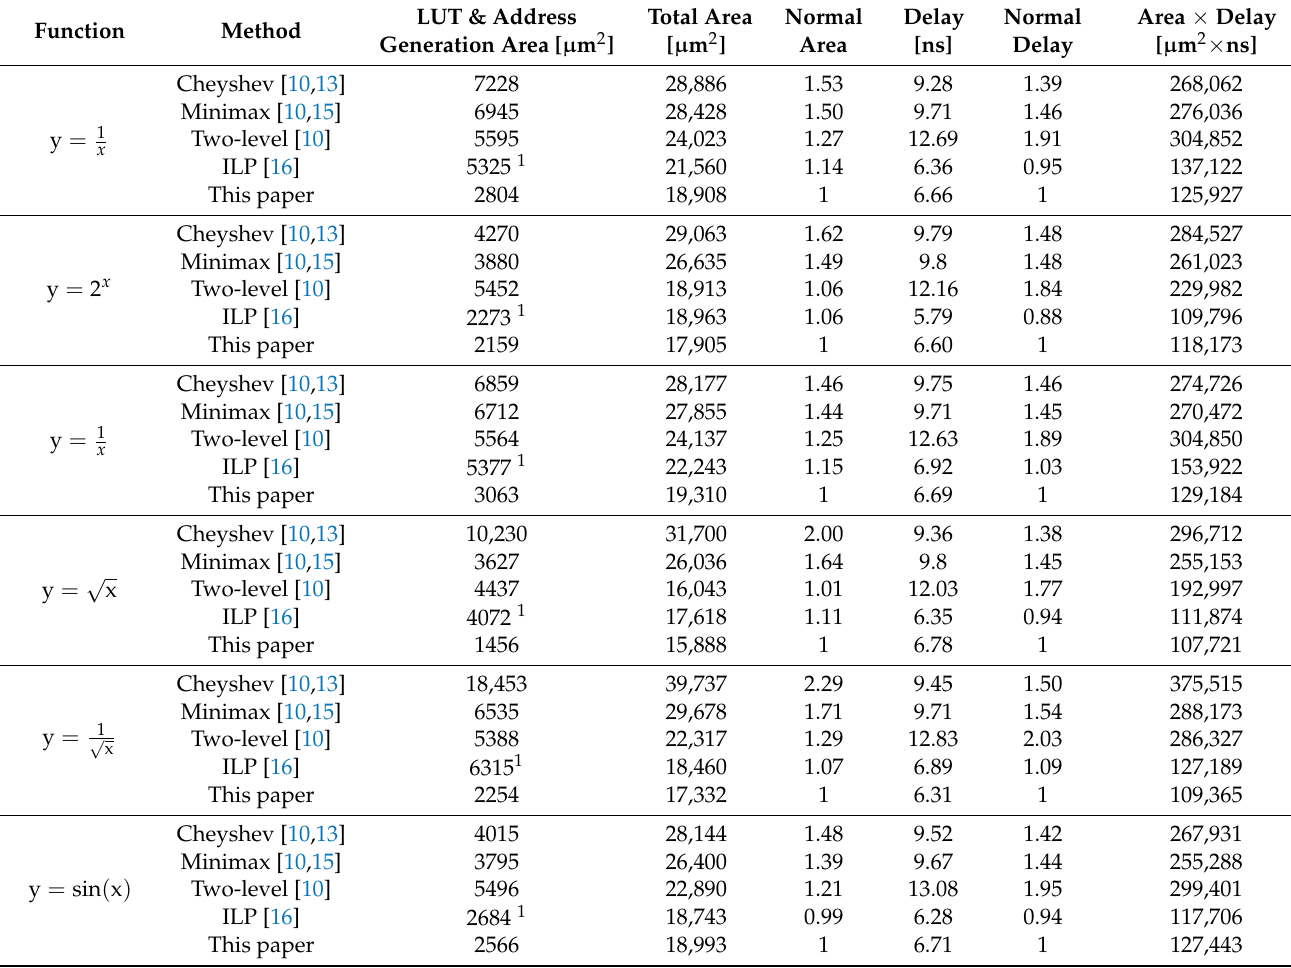
Figure 10. Hardware architecture for multi-function unit. Table 6. Comparison of synthesized